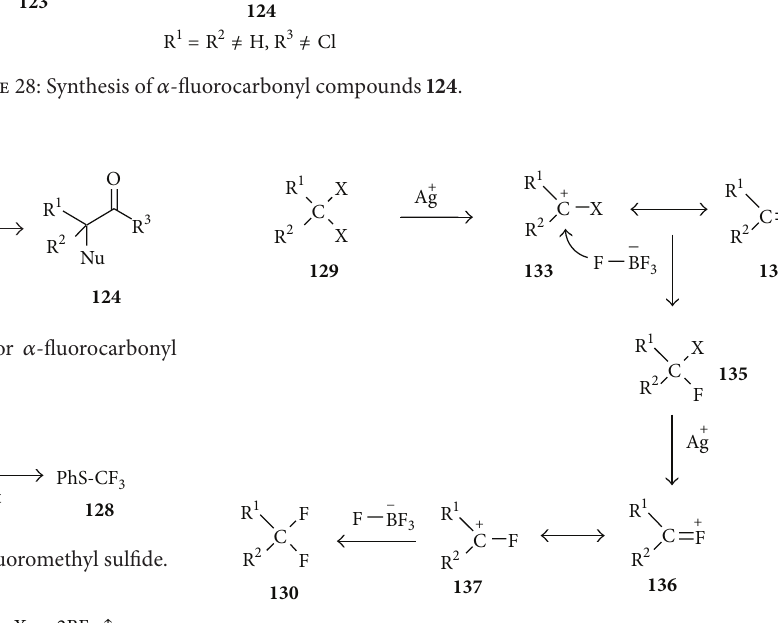
Scheme 32: Mechanism of exchange-fluorination by reaction with AgBF 4 .